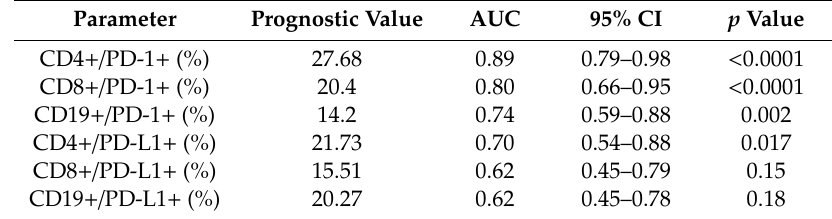
Table 5. Receiver operating characteristic (ROC) analysis to determine diagnostic accuracy in